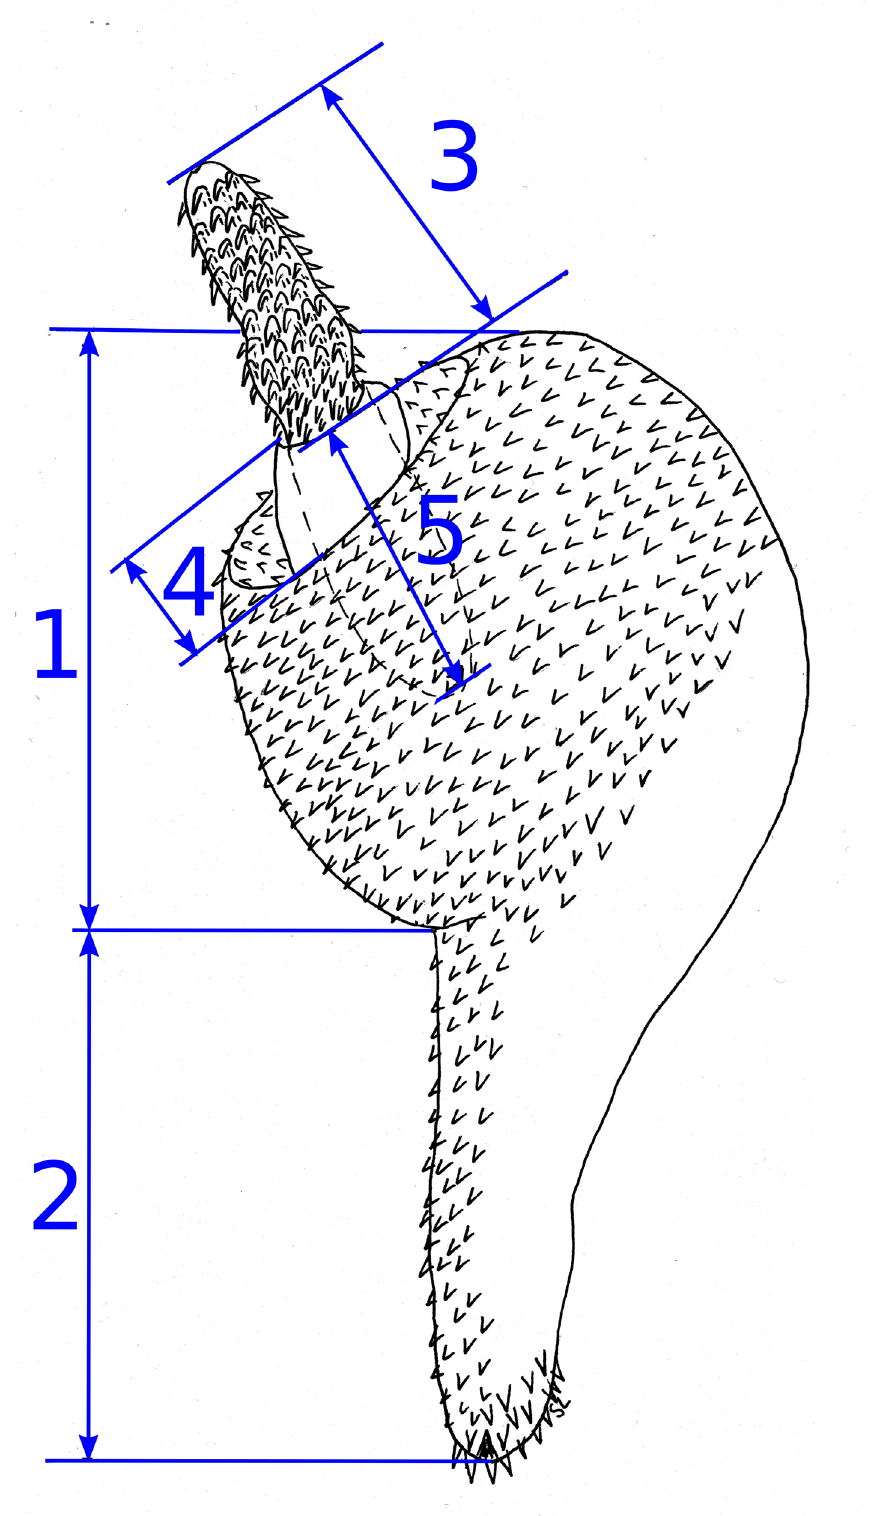
Fig. 2. Schematic diagram of praesoma and trunk of a male of Corynosoma semerme illustrating the length measurements recorded from all three species of Coryonosma ; internal organs except proboscis receptacle excluded. 1 = fore-trunk. 2 = hind-trunk. 3 = proboscis. 4 = neck. 5 = proboscis